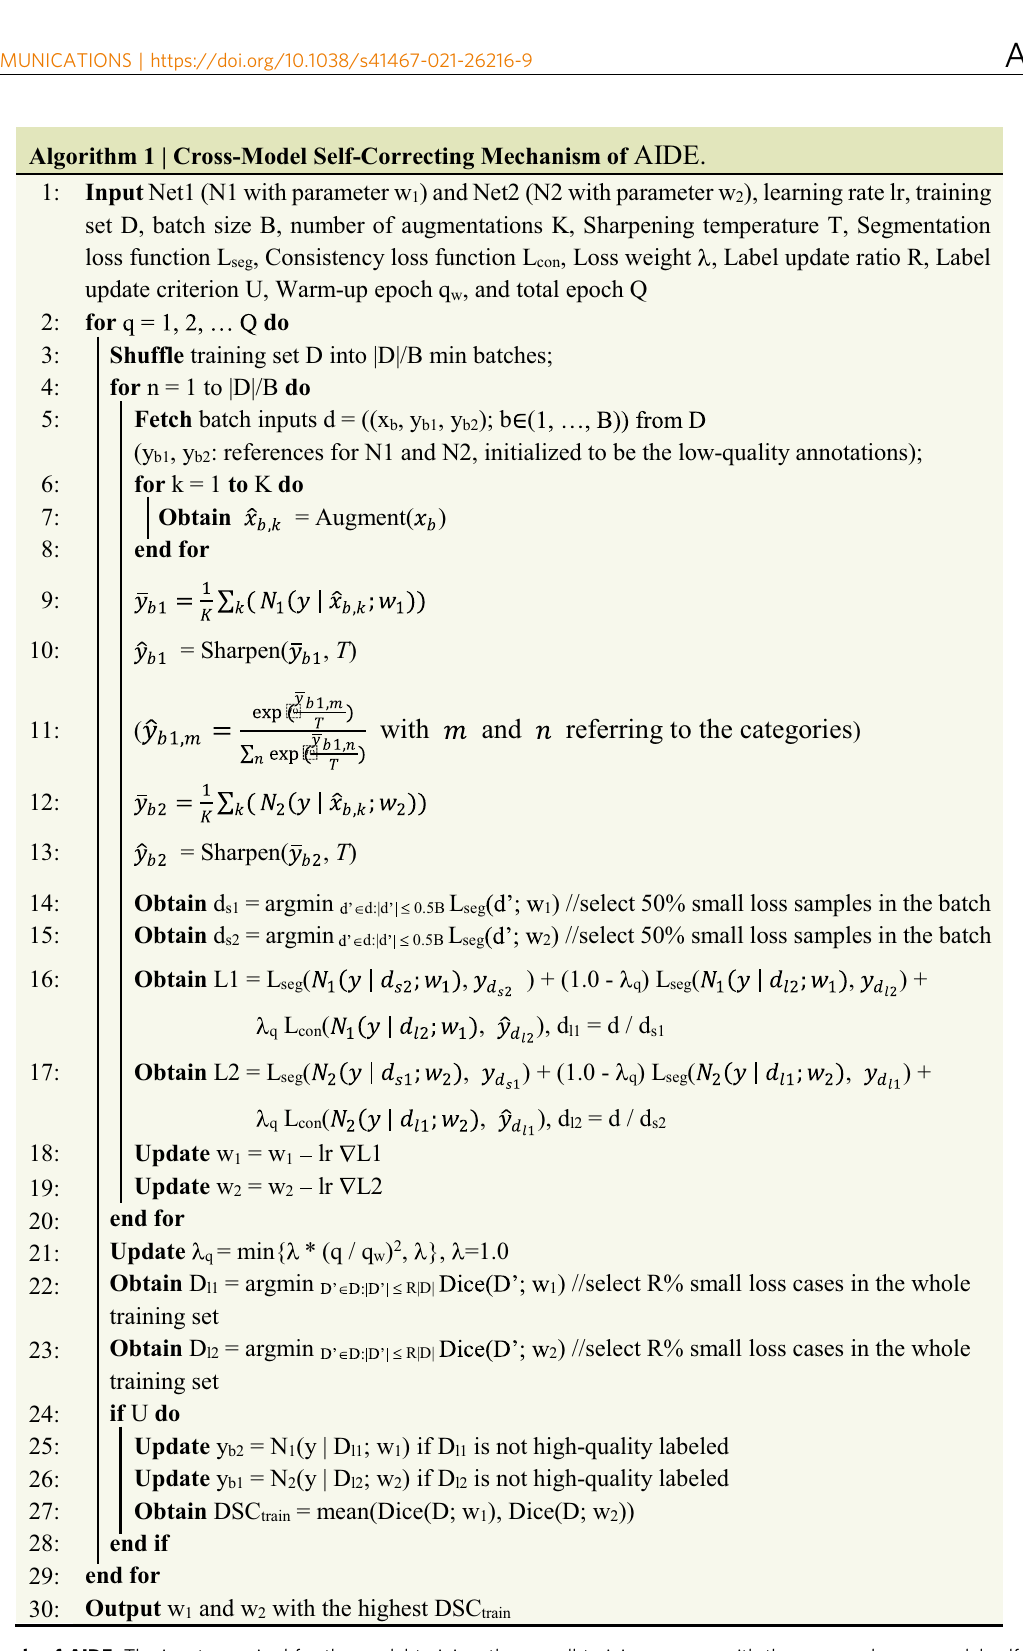
Fig. 5 Pseudo-code of AIDE. The inputs required for the model training, the overall training process with the proposed cross-model self-correcting mechanism, and the optimized model to be saved are features corresponding to the background and target segmentation maps, and a softmax activation is included to generate the segmentation probability maps. Evaluation metrics . Different metrics can be used to characterize the segmentation results. For our experiments, we choose the commonly utilized Dice score (Dice